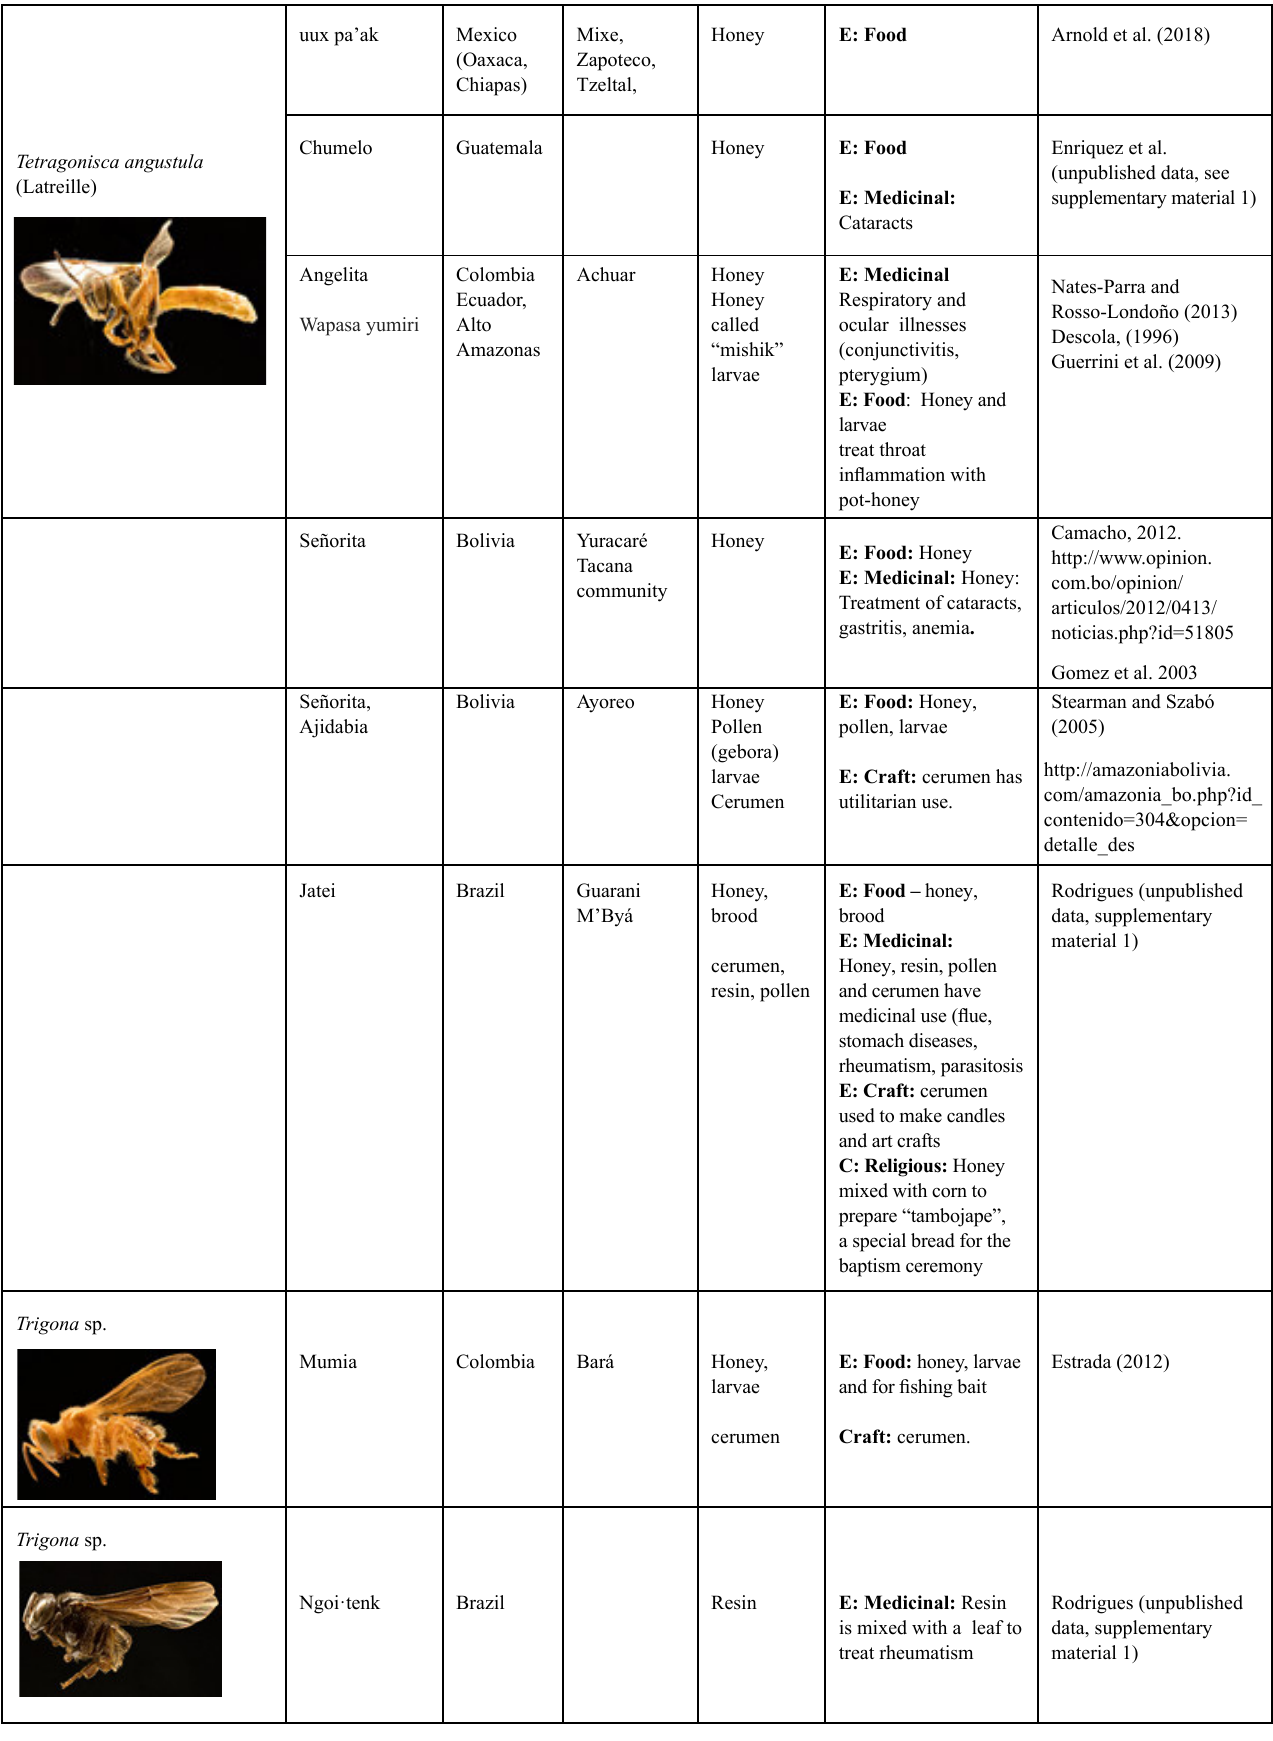
Table 1 . Economic and cultural values associated with stingless bees by different ethnic groups of tropical America.